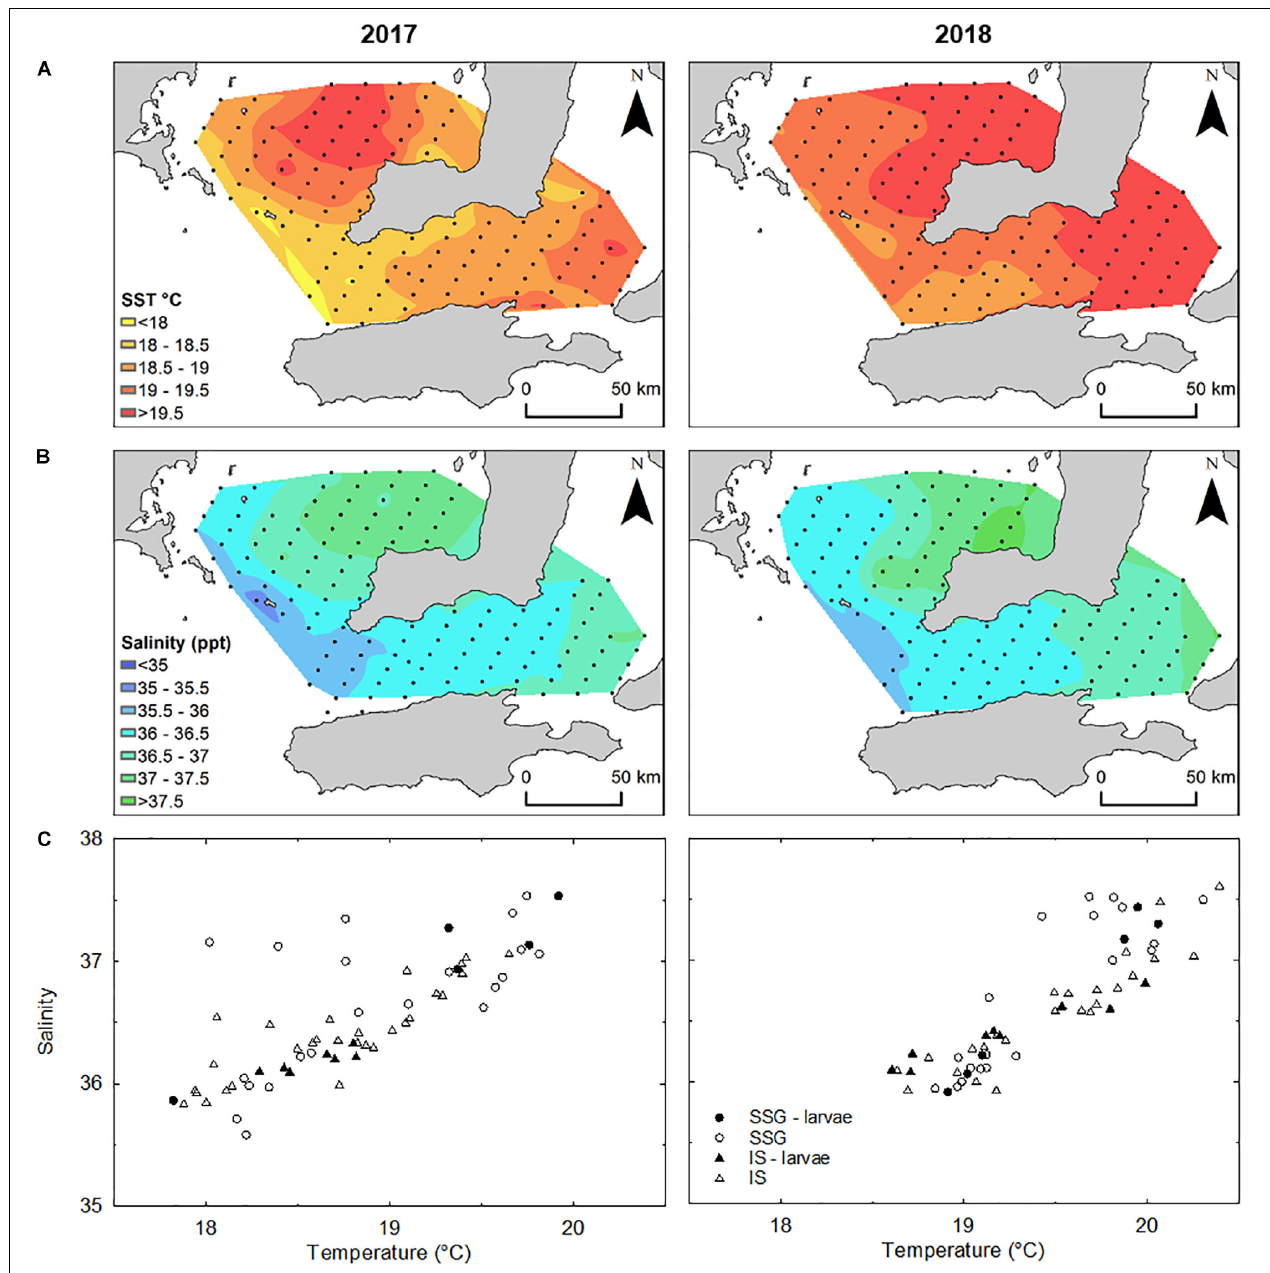
FIGURE 5 | (A) Interpolated mean temperature ( ◦ C) and (B) salinity to a depth of 5 m from the surface determined from CTD casts ( n = 62) in 2017 and 2018. (C) Temperature-Salinity plots for sampling stations where CTD casts were done in each year. Stations where larvae were captured and used in otolith analyses are represented by closed